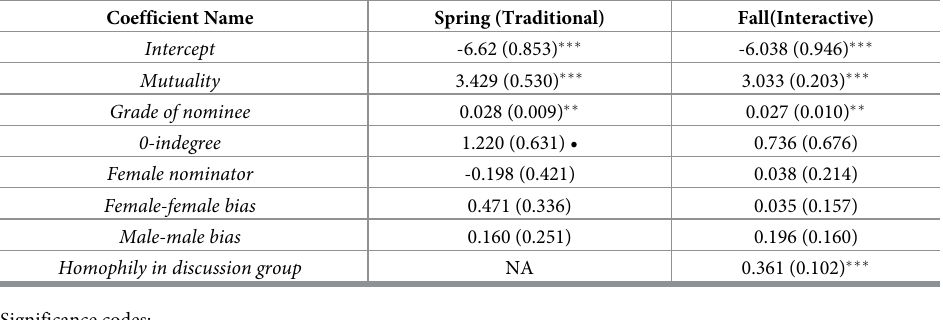
Table 2. Coefficients from exponential random graph modeling (ERGM) for both offerings, with standard errors in